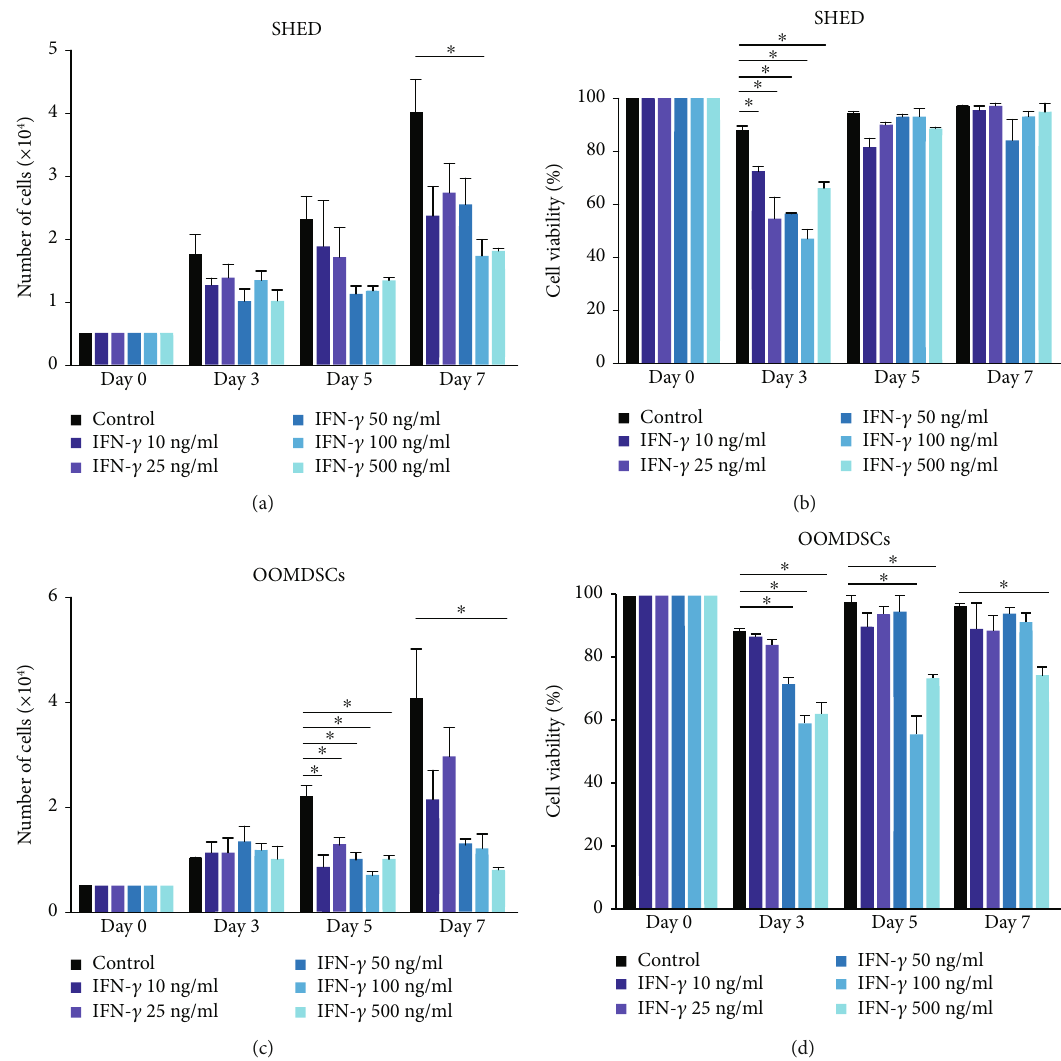
Figure 3: E ff ects of IFN- γ on the proliferative capacity and cell viability of SHED and OOMDSCs. (a) An inhibition of cell proliferation in SHED was observed after three days of culture in culture medium supplemented with IFN- γ at di ff erent concentrations. After the fi fth day of culture, it was observed that the addition of IFN- γ at higher concentrations (100ng/mL and 500ng/mL) to the culture medium resulted in a greater inhibition of the proliferation of SHED than the addition of IFN- γ at lower concentrations (10 ng/mL, 25ng/mL, and 50 ng/mL); however, this di ff erence was not statistically signi fi cant. A similar e ff ect was observed after seven days of cell culture; however, a statistically signi fi cant reduction in the cell proliferation of SHED treated with IFN- γ at the 100 ng/mL concentration compared with that of untreated SHED was observed. (c) An inhibition of proliferation in OOMDSCs was observed after fi ve days of culture in culture medium supplemented with IFN- γ at di ff erent concentrations. Beginning on the fi fth day of culture, it was observed that compared with no IFN- γ addition, the addition of IFN- γ to the culture medium resulted in a statistically signi fi cant inhibition of OOMDSC proliferation. After seven days of culture, the addition of IFN- γ at higher concentrations (50ng/mL, 100ng/mL, and 500ng/mL) to the culture medium resulted in a greater inhibition of OOMDSC proliferation; however, compared with the OOMDSCs maintained in culture medium without IFN- γ , only the OOMDSCs treated with IFN- γ at 500 ng/mL had their proliferation signi fi cantly inhibited. (b) A statistically signi fi cant decrease in the cell viability of SHED was observed only on the third day of culture in culture medium supplemented with IFN- γ at distinct concentrations. Furthermore, a greater decrease in the viability of SHED was detected in the groups treated with IFN- γ at a 25ng/mL, 50ng/mL, or 100 ng/mL concentration than in the groups treated with lower concentrations of IFN- γ . No signi fi cant di ff erences were observed among the populations of SHED after fi ve or seven days of culture in culture medium supplemented with IFN- γ at distinct concentrations. (d) For OOMDSC populations, a statistically signi fi cant decrease in cell viability on the third day of culture was observed only when the cells were treated with IFN- γ at 50ng/mL, 100ng/mL, or 500ng/mL. On the fi fth day of culture, however, a statistically signi fi cant decrease in cell viability was observed only when OOMDSCs were treated with IFN- γ at 100 ng/mL or 500ng/mL. Additionally, a statistically signi fi cant decrease in cell viability was observed on the seventh day of culture only when OOMDSC populations were treated with IFN- γ at a concentration of 500ng/mL. ∗ p < 0 : 05 , determined by two-way ANOVA followed by the Bonferroni post hoc test. Five experimental replicates were performed for each group for both SHED and